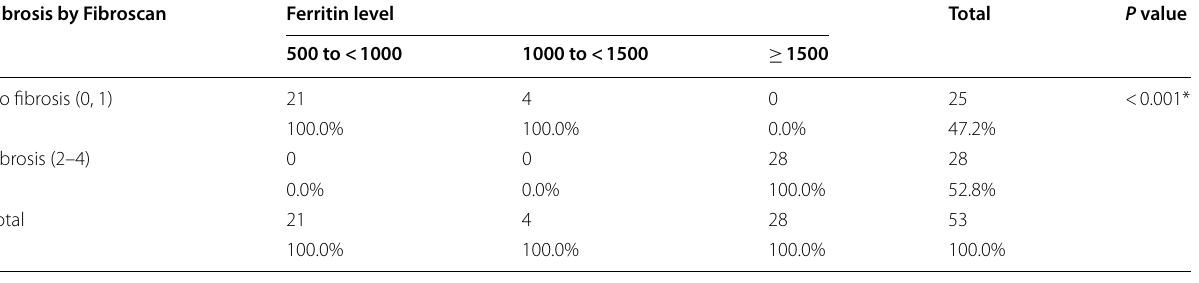
Table 5 Relation between significant fibrosis (2–4) by Fibroscan and ferritin level categories Fibrosis by Fibroscan